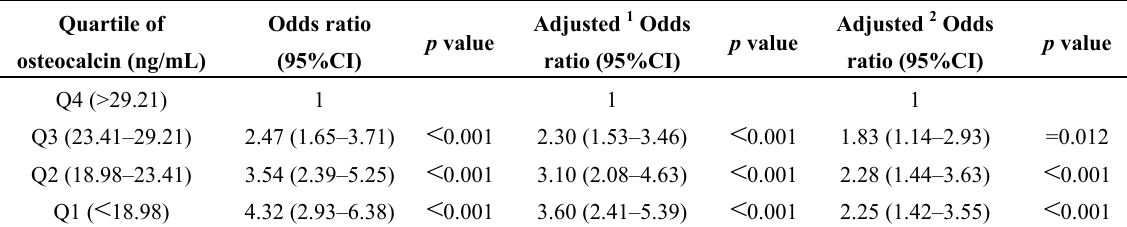
Table 3. Binary logistic regression model examining associations of serum osteocalcin level and the presence of non-alcoholic fatty liver disease (NAFLD) Age-adjusted Spearman correlations between osteocalcin and variables.